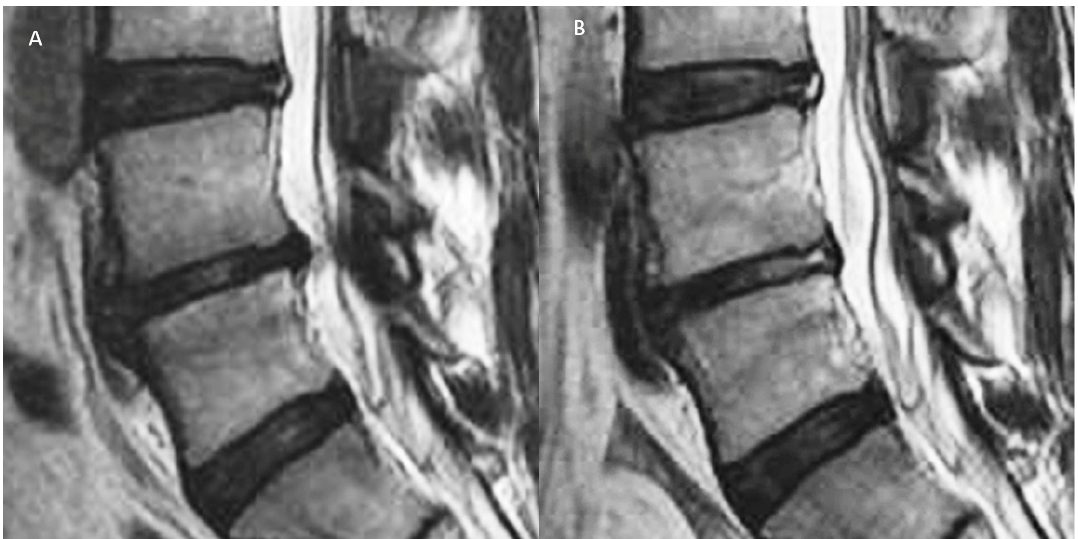
Figure 2. A : Degenerative disc disease with Pfirrmann grade III disc showing an inhomogeneous structure, and an unclear distinction of nucleus and annulus and type 1 Modic changes with intermediate signal intensity in the T2 image with slightly decreased disc height and disc bulge. B : After radiofrequency ablation of the disc, sinuvertebral nerve, and basivertebral nerve, there is shrinkage of the degenerative disc and there is an increase in the signal of Modic changes in the adjacent vertebra body. However, with the current imaging technique, there are limitations in quantifying the effects of these end plate changes objectively. Further development in this area of assessment would be beneficial to assess treatment effects on the end plate and disc in early DDD (figure reproduced with permission courtesy of Kim et al. [12]) .